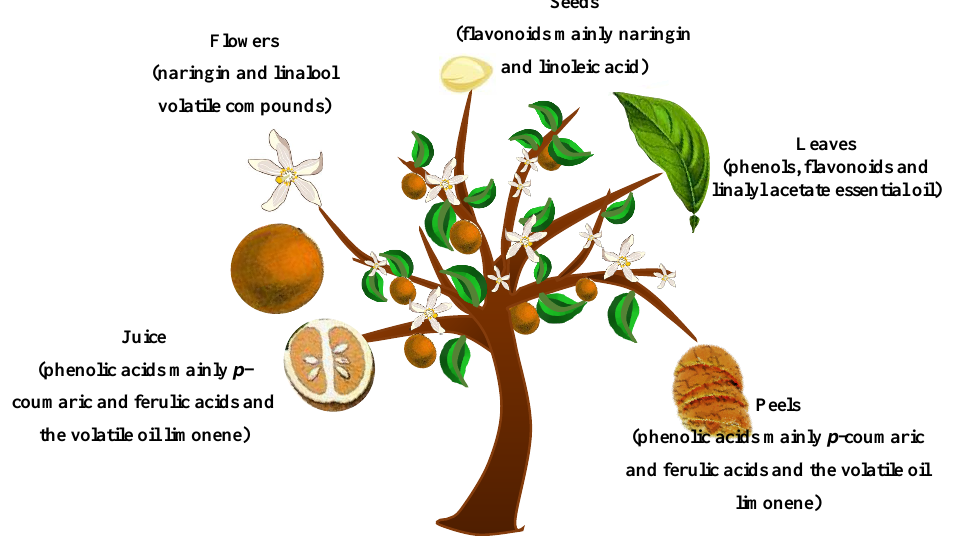
Figure 1. C. aurantium (bigarade) tree with the studied plant parts and the most abundant active constituents.